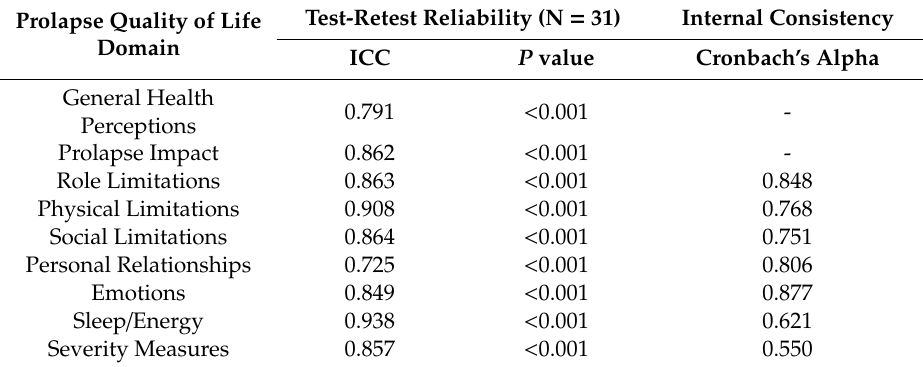
Table 4. Reliability of P-QoL domain scores.